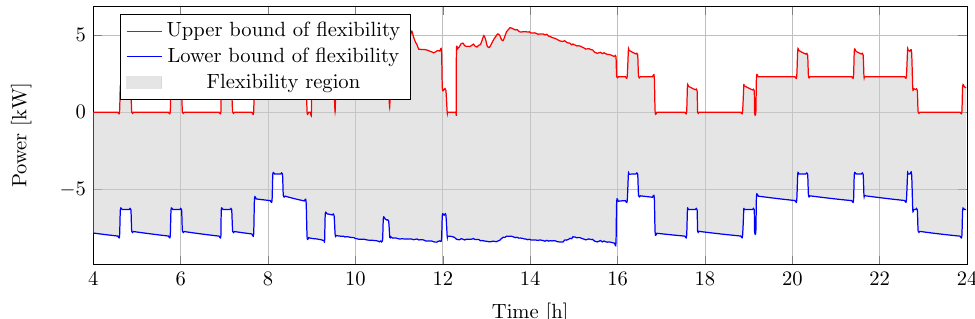
Figure 10. Available upward and downward flexibility for the winter cloudy day scenario.